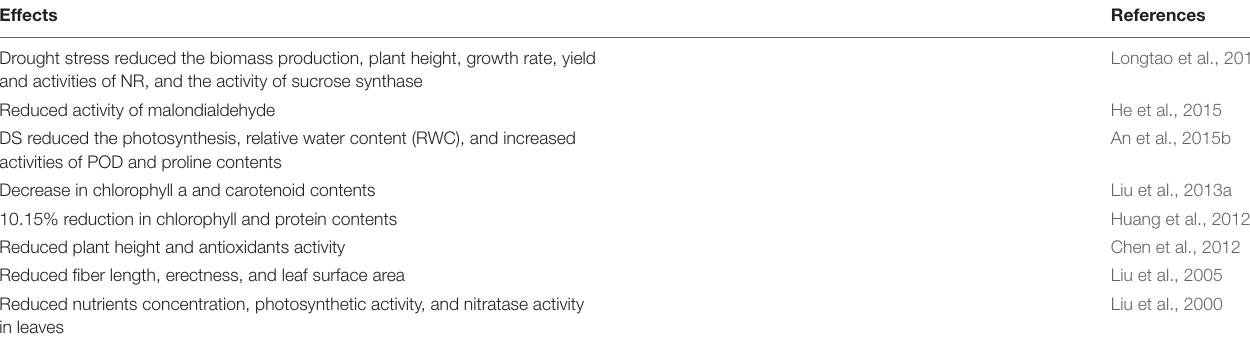
TABLE 1 | Effects of DS on growth, yield and physiological traits of ramie